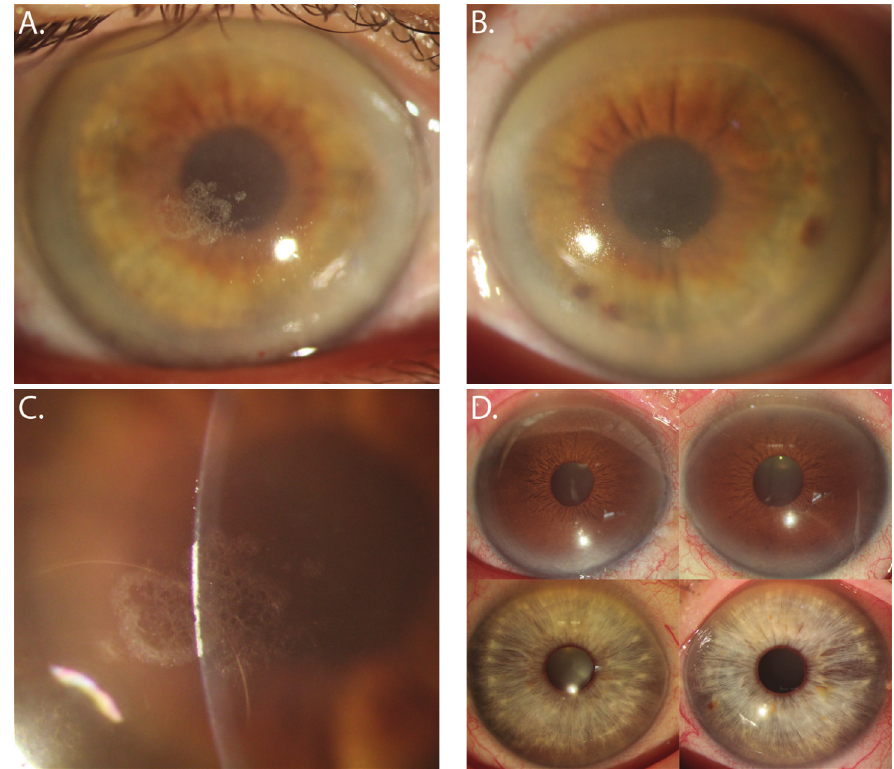
Figure 2: Slit lamp photomicrographs of 47-year-old woman with Schnyder corneal dystrophy. (A) Diffuse illumination of the right eye demonstrates arcus lipoides and a central crystalline deposit. (B) Diffuse illumination of the left eye also demonstrates dense arcus lipoides, central discoid haze, and a focal central crystalline deposit overlying the inferior pupillary border. (C) Slit illumination of the right eye demonstrates the subepithelial location of the crystalline deposit. (D) Slit lamp photomicrographs of the proband’s father demonstrate arcus senilis but no central stromal opacification in either the right or left eye (top images). The proband’s mother’s corneas are clear (bottom